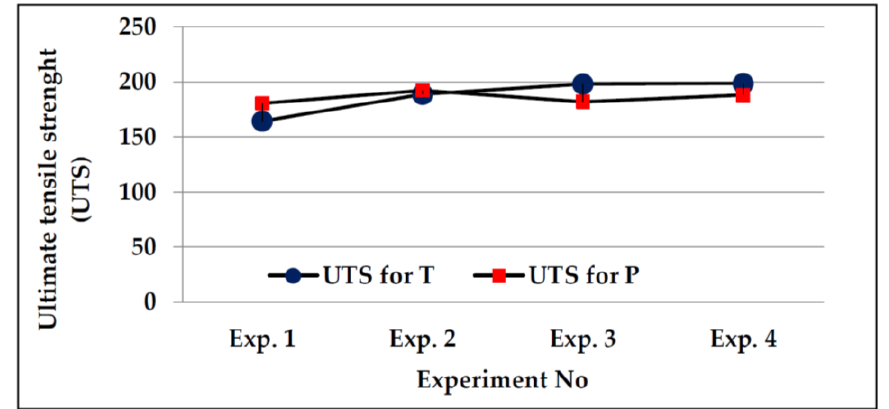
Figure 6. The comparative UTS results for both tool pins.